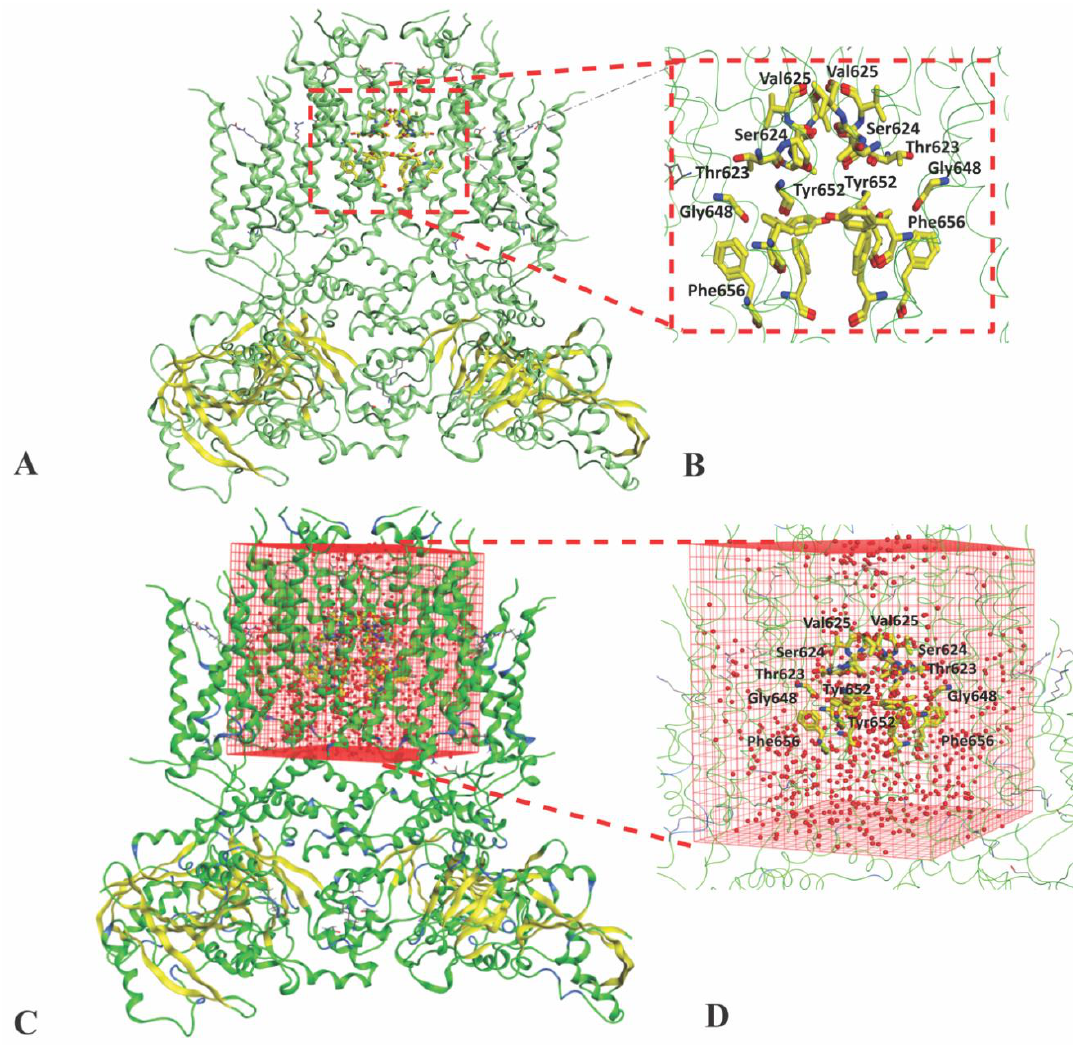
Figure 1. hERG cryo_EM structure in open conformational state ( A ) Binding cavity residues highlighted in non-solvated binding cavity structure. ( B ) Zoom in view of mutagenesis residues of non-solvated-open binding cavity. ( C ) Cryo_EM structure of hERG within simulated water box. ( D ) Zoom in view of solvated-open binding cavity showing mutagenesis amino acid residues and water